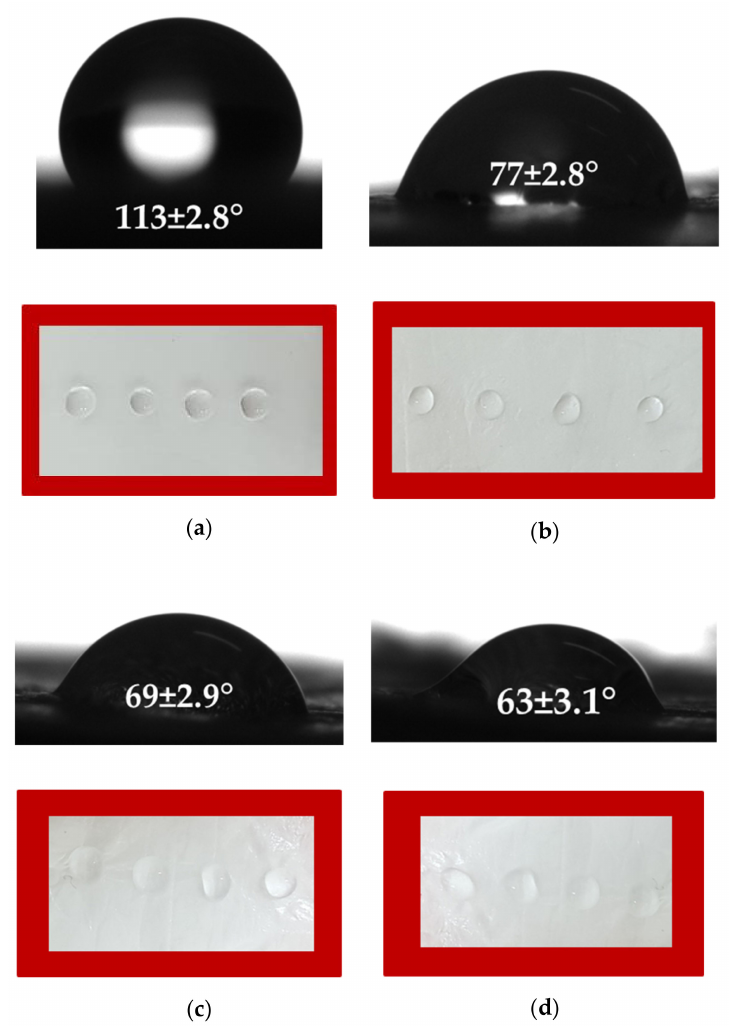
Figure 2. Digital images of water droplets spotted on the surface of fibrous biomaterials: ( a ) PLLA mat, ( b ) PLLA mat coated with oligochitosan, ( c ) PLLA mat coated with LMW chitosan and ( d ) PLLA mat coated with HMW